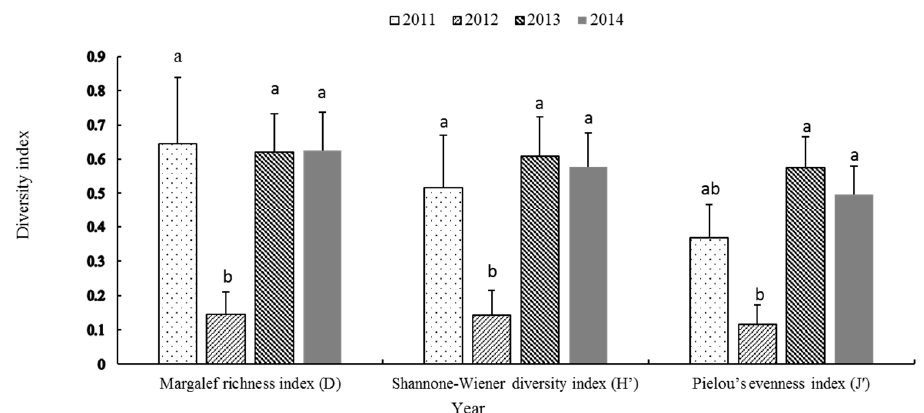
Figure 7. Species diversity index values of fish eggs and larvae collected from the Yellow River estuary in this study. a, b: the significant difference between groups.